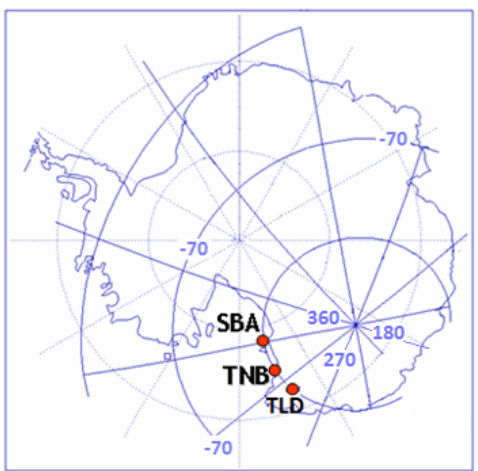
Figure 1. Location of the three Antarctic sites TNB, SBA and TLD. The geographic and the corrected geomagnetic coordinate systems are indicated as dashed and solid lines,